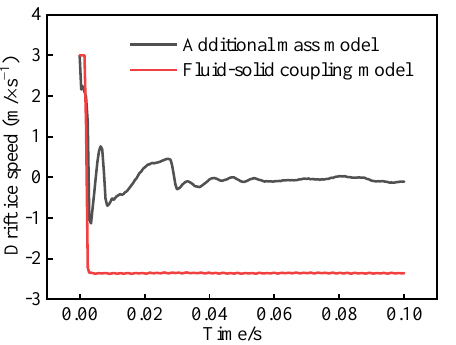
Figure 9. Time–history curves of flow ice velocity under different collision Figure 9. Time – history curves of flow ice velocity under different collision models.